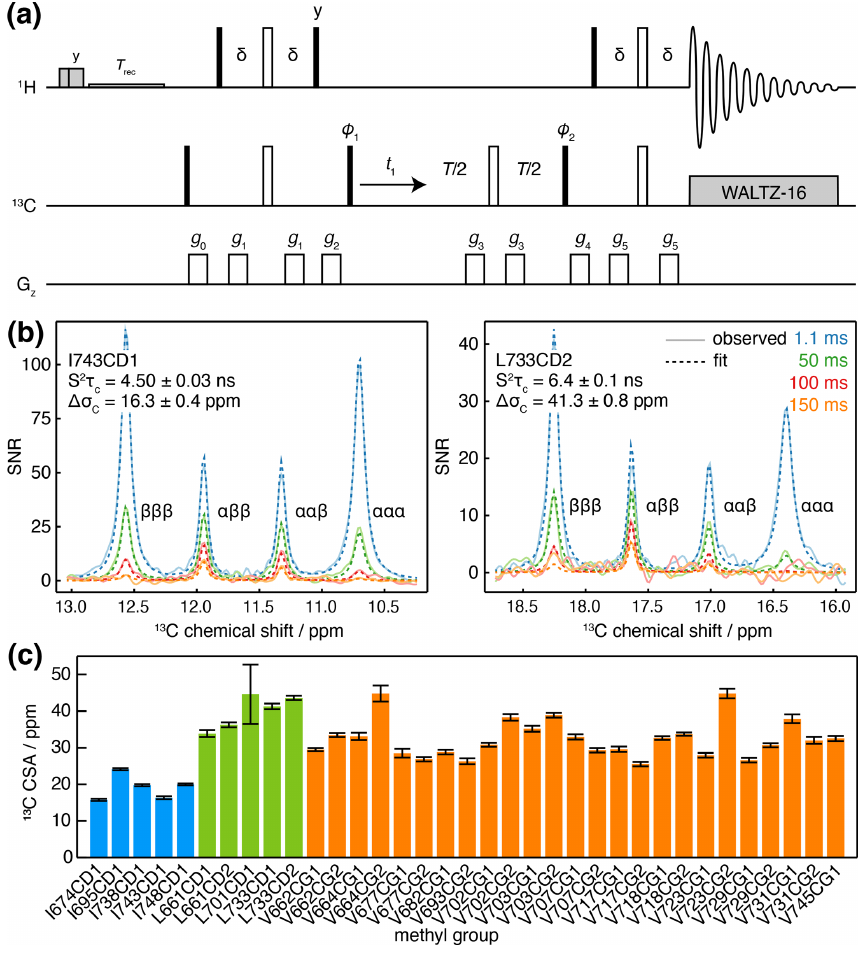
τ c . (a) 1 H-coupled HSQC with 13 C Hahn echo. T represents the relaxation time, and Figure 3. Measurement of methyl 13 C CSA and S 2 axis the delay δ = 1 / 4 J = 2ms. Shaded grey pulses represent consecutive 5kHz 2ms H x and 3ms H y purge pulses before the recycle delay, T rec (with low-power presaturation applied, if required). φ 1 = x , − x ; φ 2 = x , x , − x , − x ; receiver phase = x , − x , − x , x . Trapezoidal gradients were applied with the following powers and lengths: g 0 25Gcm − 1 , 1ms; g 1 7Gcm − 1 , 1ms; g 2 9Gcm − 1 , 1ms; g 3 22Gcm − 1 , 300µs; g 4 18Gcm − 1 , 1ms; g 5 16Gcm − 1 , 1ms. States-TPPI quadrature detection in t 1 was achieved by incrementation of φ 1 . (b) Cross-sections through 13 C multiplets of isolated FLN5 methyl groups measured according to the pulse sequence in panel (a) , with relaxation delays as indicated, acquired at 283K, 950MHz ( 1 H Larmor frequency). Cross-sections through the fitted spectra are also shown by dashed lines, with τ c and (cid:49)σ C indicated. (c) Measured values of methyl 13 C CSA in FLN5, 283K, coloured according to the residue the fitted values of S 2 axis type. Error bars indicate the standard error determined from